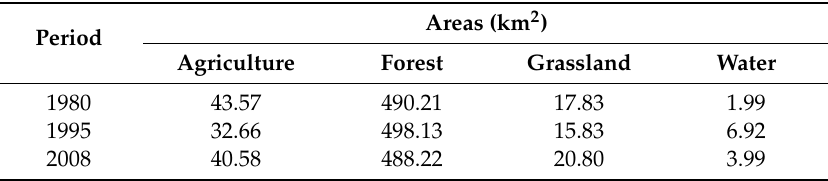
Table 9. Land use areas in 1980, 1995 and 2008.